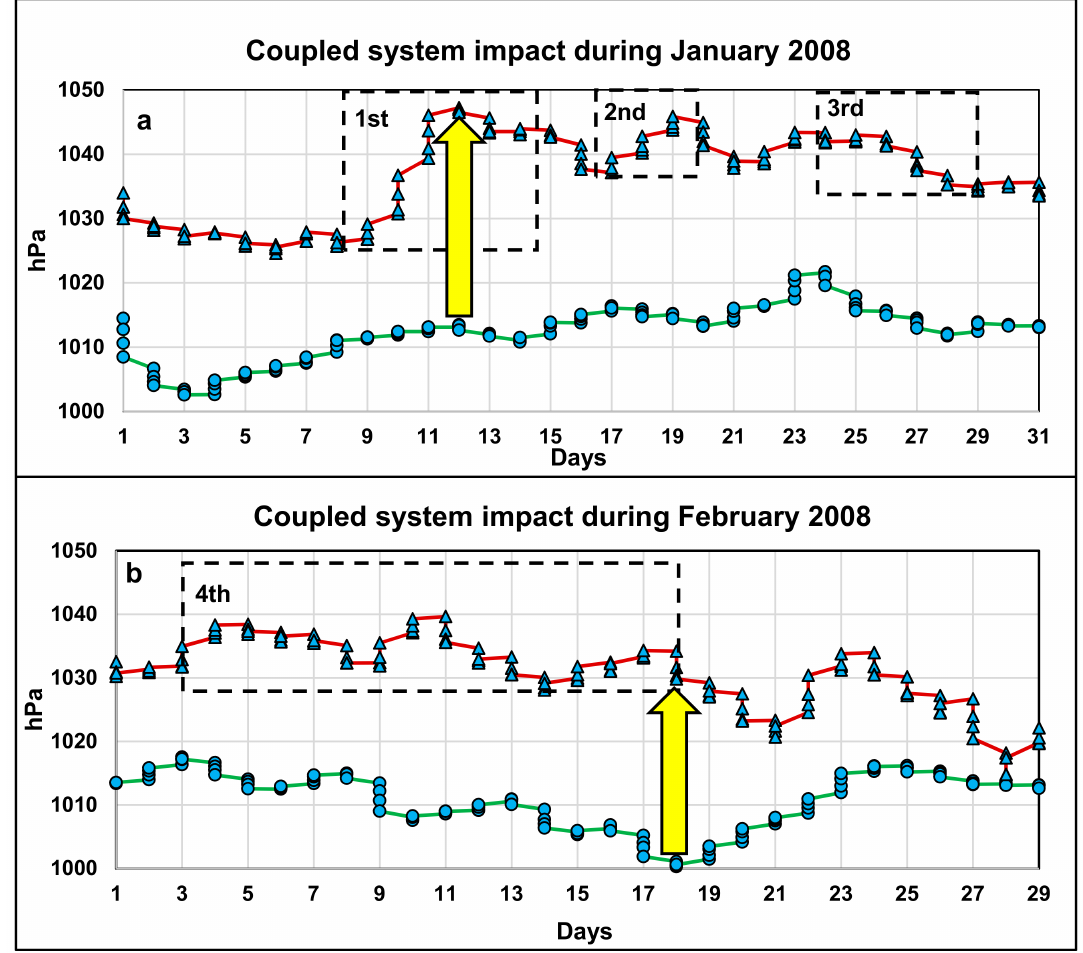
Figure 5. MSLP over the SH and AL domain for ( a ) January 2008 and ( b ) February 2008 computed at 00:00, 06:00, 12:00, and 18:00 UTC. Red lines in ( a ) and ( b ) indicate intraday MSLP over the SH and green lines in ( a ) and ( b ) indicate intraday MSLP over the AL. Yellow arrows in ( a ) and ( b ) indicate the maximum PD between SH and AL systems attained during the month. “1 st ”, “ 2 nd ”, “3 rd ” and “4 th ” in the figure represent the categorized CSE episodes. Data from the ECMWF, ERA-Interim. For the CSE during January–February 2008, a very distinct pattern of zonal JS as an elongated continuous stretch of JS extending from 70 ◦ E to 180 ◦ E is observed (Figure 6a). This pattern originated on 26 January 2008 at 00:00 UTC and continued nearly for 20 days remaining until 15 February at 12:00 UTC (Figure 6b), largely overlapping with the HKO recorded cold spell duration of 24 January to 16 February 2008. This JS later started to split from 15 February 2008 at 18:00 UTC and further weakened as it moved